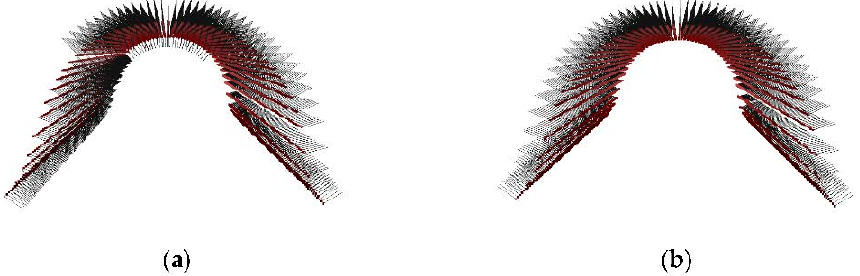
Figure 9. Normal vector orientation: ( a ) ambiguity of point cloud normal vector and ( b ) consistency of point cloud normal vector.